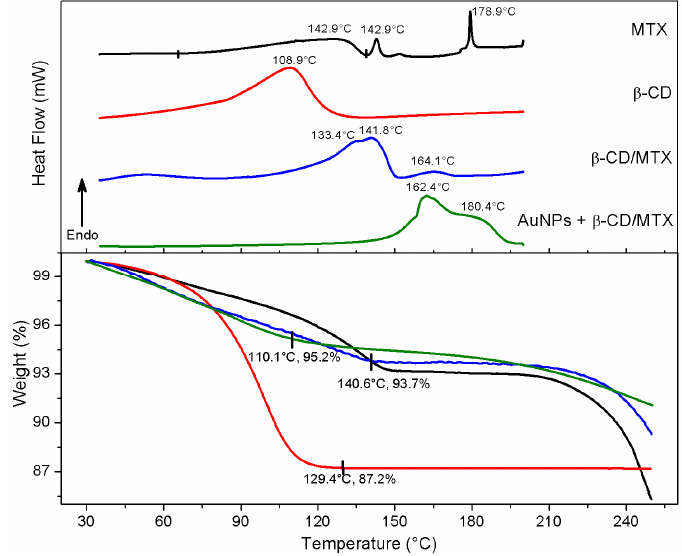
Figure 7. TGA and DSC analysis of MTX, IC, and AuNPs + IC.